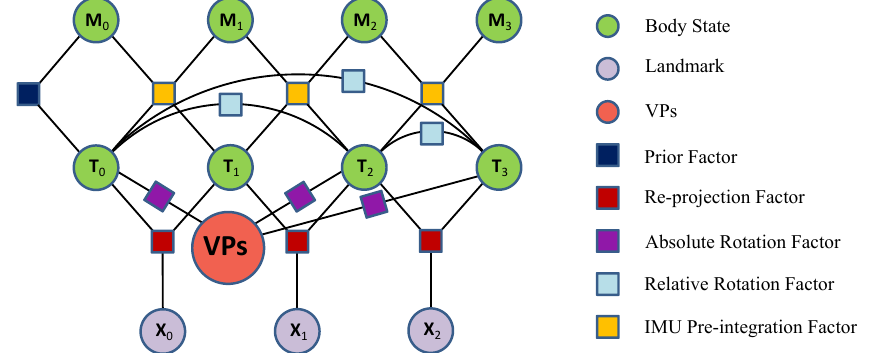
Figure 4. The factor graph represents our optimization problem. Circles represent the states of being optimized, and squares represent the factors as probability constraints between